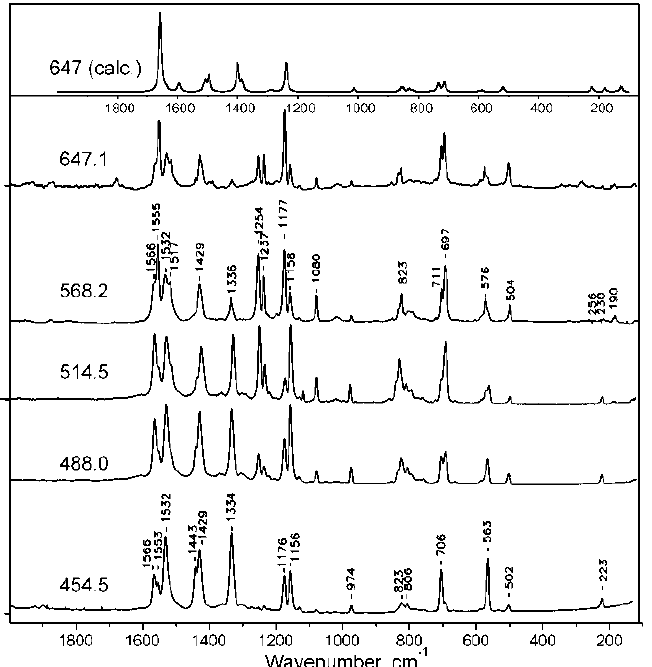
Figure 10. Resonance Raman spectra of H 2 TTDPz at different excitations (454.5, 514.5, 568.4,